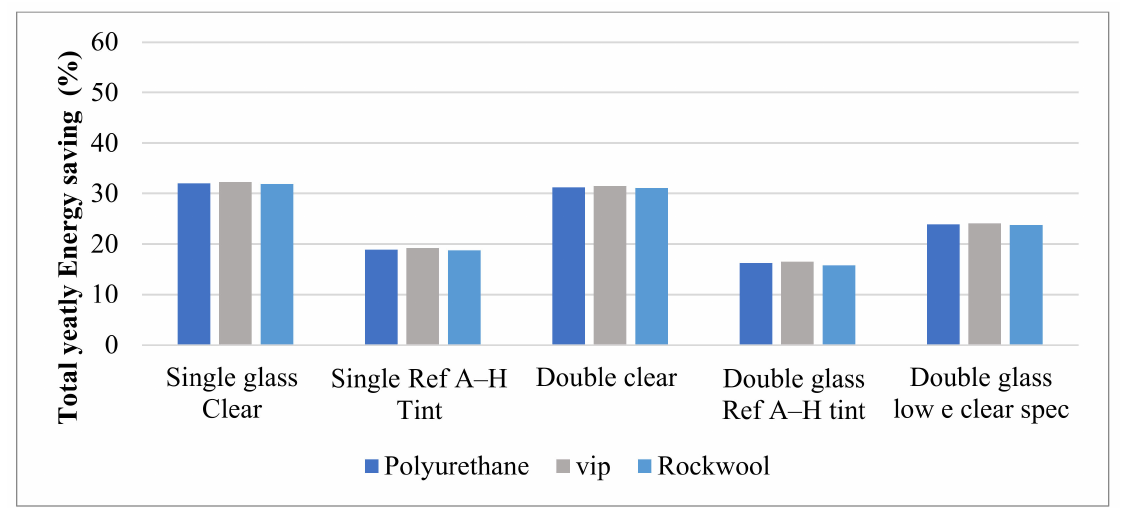
Figure 7. Yearly reduction in the total energy consumption of the building applying different types of window glass integrating three types of window shutters’